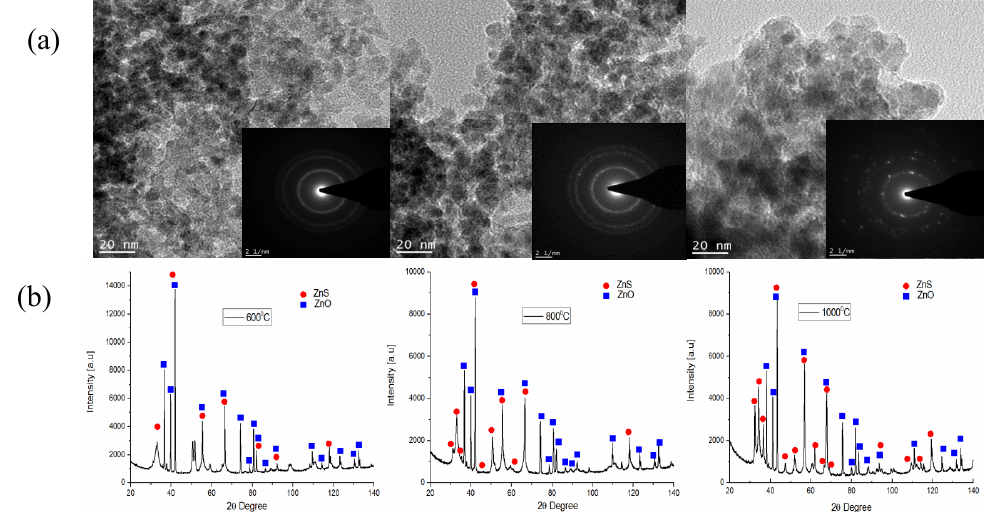
Figure 7. ( a ) Transmission electron microscopy (TEM) image and selected area electron diffraction (SAED) patterns, ( b ) XRD pattern of carbon residue after selective thermal transformation for 15 min at 600 °C, 800 °C, and 1000 °C.